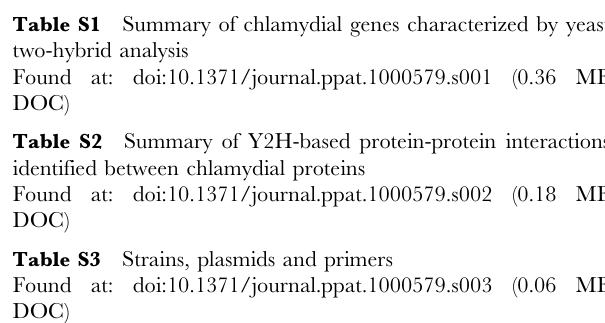
Table S1 Summary of chlamydial genes characterized by yeast two-hybrid analysis